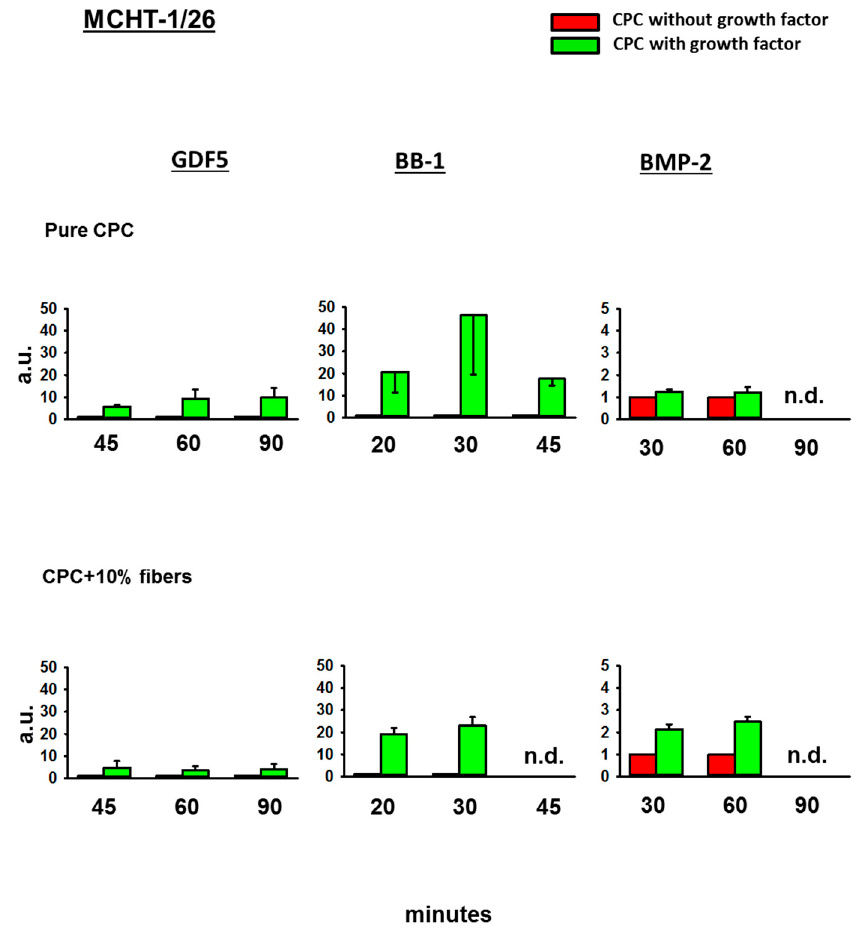
Figure 6. Alkaline phosphatase (ALP) activity in MCHT-1/26 cells. MCHT-1/26 cells were cultivated for 3 days in diluted extracts of GDF5, BB-1, or BMP-2-containing, ground pure CPC or PLGA fiber-reinforced CPC. Thereafter, the ALP activity was measured using an ALP assay and the data were expressed as fold-change induction compared to the CPC without growth factor; data are expressed as means ± SEM ( n = 3); n.d. = not determined; a.u. = arbitrary units.